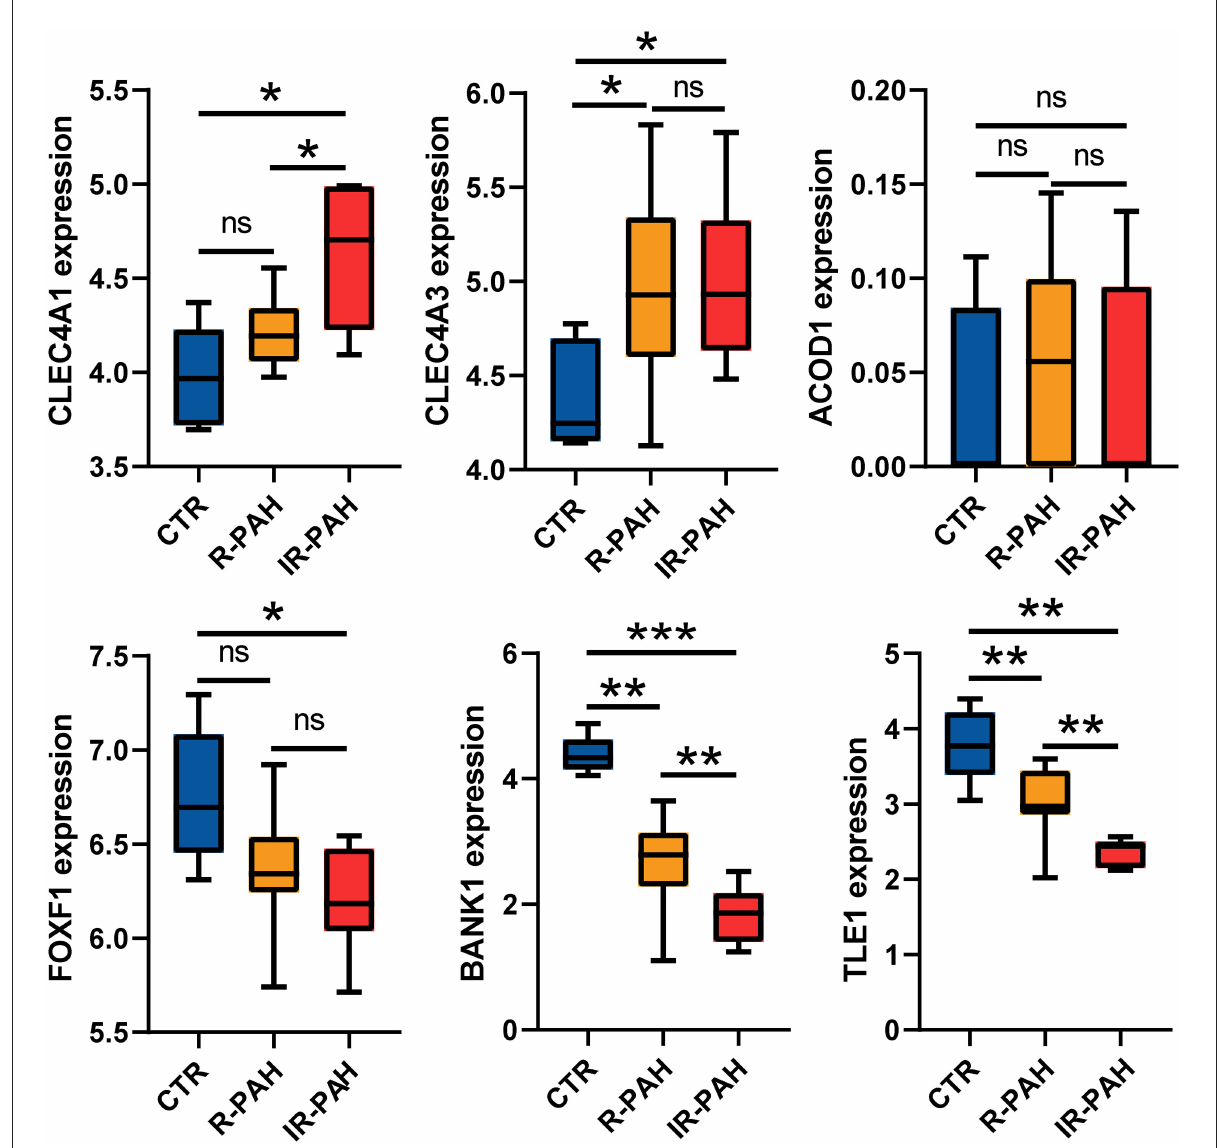
FIGURE8 Validation of the hub genes. Boxplots showing the expression level of six real hub genes in dataset GSE149899. * P < 0.05, ** P < 0.01, *** P < 0.001, ns, no significance. CTR, control; R-PAH, reversible pulmonary arterial hypertension; IR-PAH, irreversible pulmonary arterial hypertension.